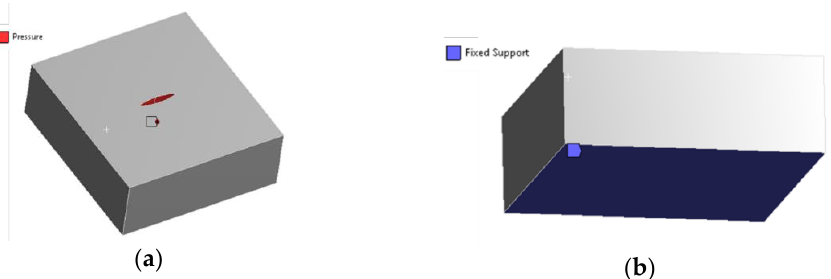
Figure 10. Surface pressure inside the fracture ( a ) and fixed support at the bottom of the formation ( b ).